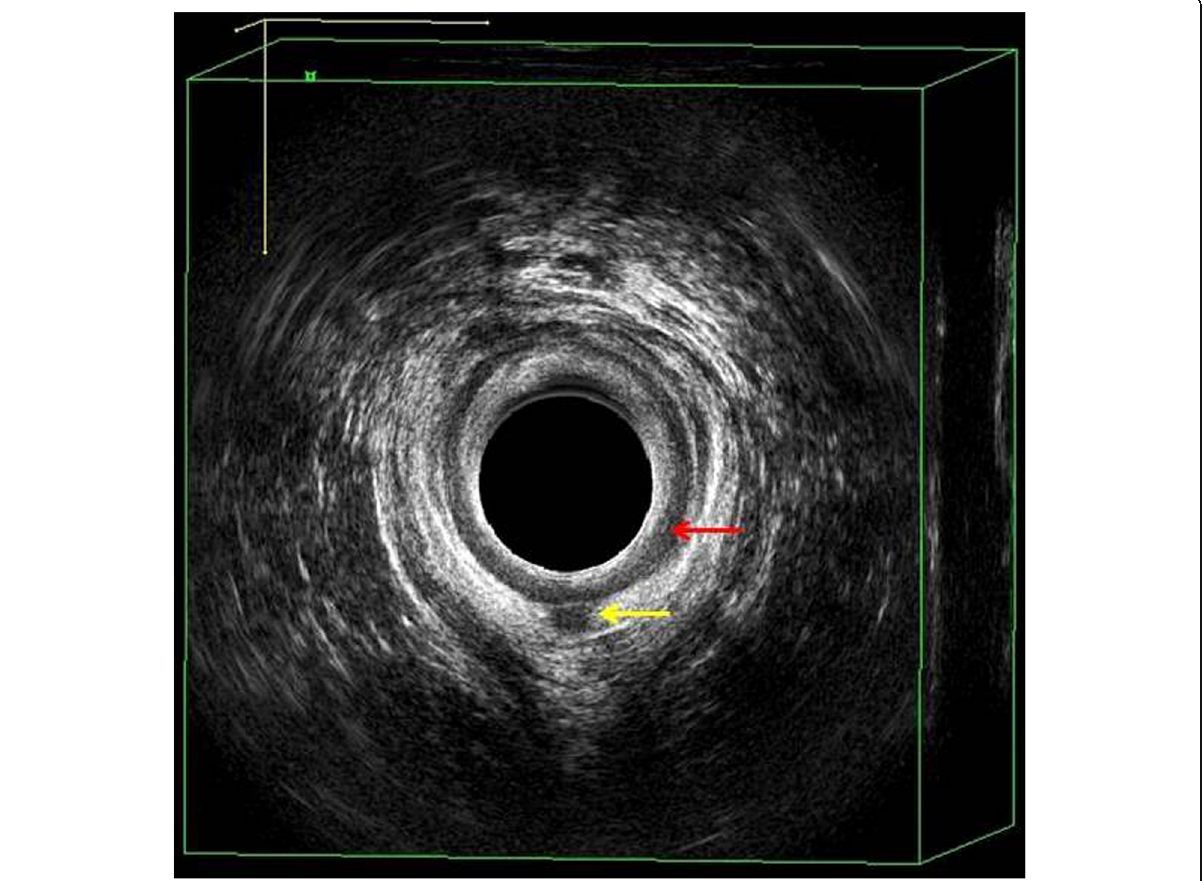
Fig. 6 3D TRUS image of intersphincteric fistula (hypoechoic area marked by the yellow arrow) at mid anal canal level. Red arrow demonstrates the hypoechoic internal sphincter ring (imaging performed with BK medical 3D Endoanal USG transducer Type 2052 with Flex focus scanner Type